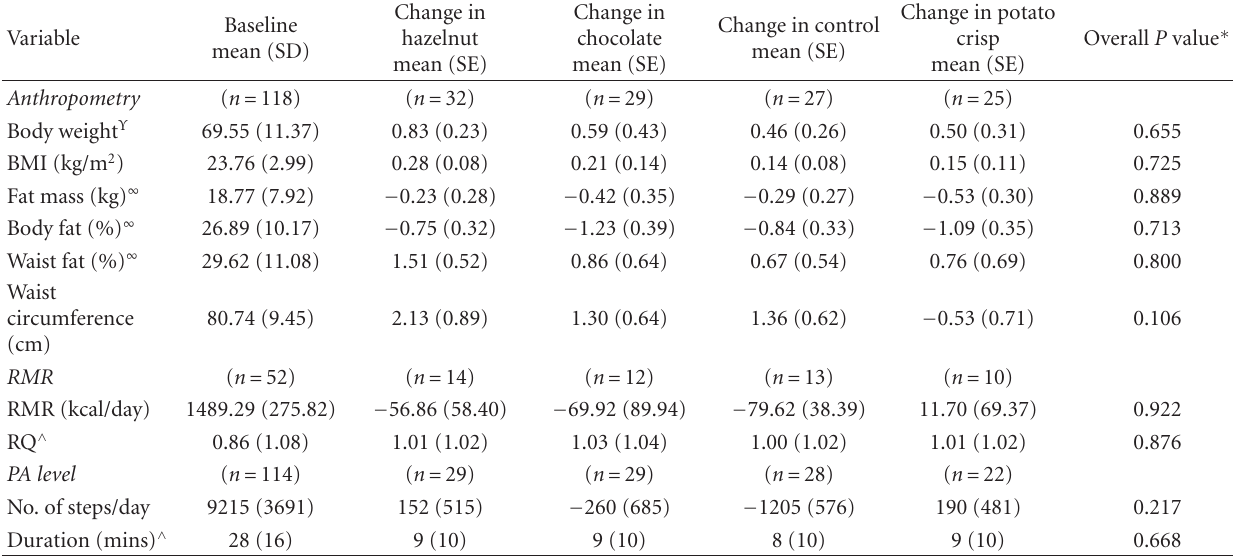
Table 3: Anthropometric measurements, resting metabolic rate and physical activity level at baseline and changes in these measurements from baseline to Week 12 for each group.